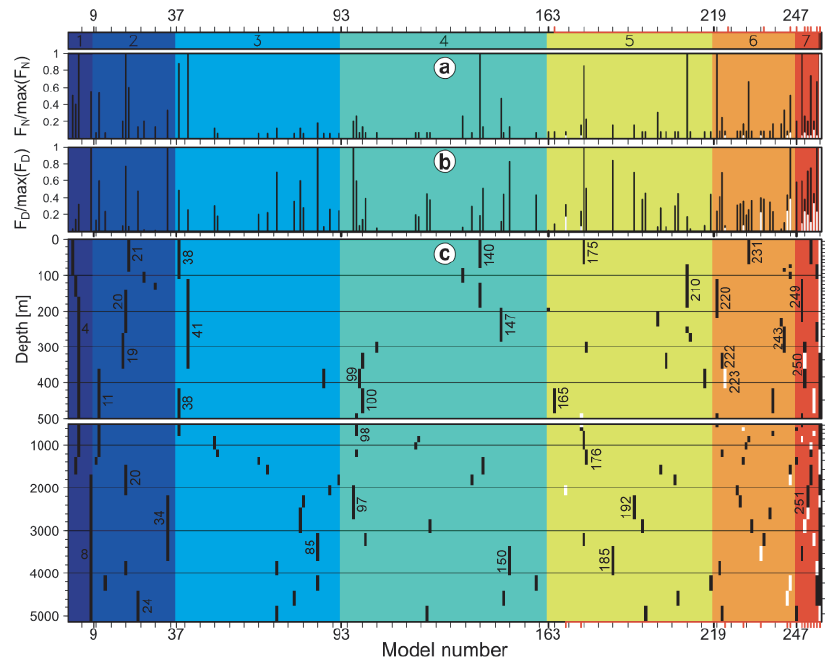
Fig. 3. Same as for Fig. 2 but using the July 2005 CLIVAR synoptic synthetic